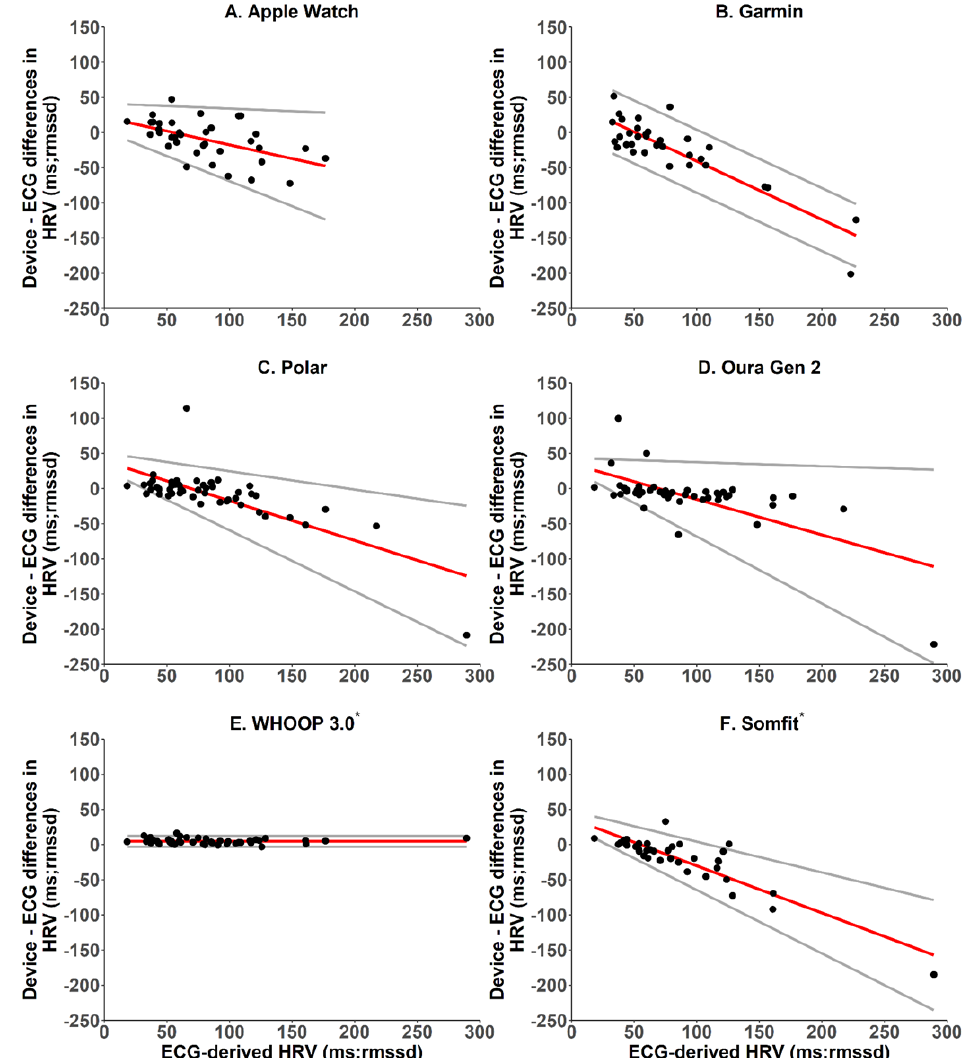
Figure 3. Bland–Altman plots for device–derived and PSG–derived measures of heart rate variability. The y–axes represent the difference between the measures—positive values indicate devices overestimate relative to PSG, and negative values indicate devices underestimate relative to PSG. Solid red lines indicate the device bias relative to PSG. Solid grey lines indicate the 95% limits of agreement (±1.96 standard deviation). * Manufacturers provided raw data.